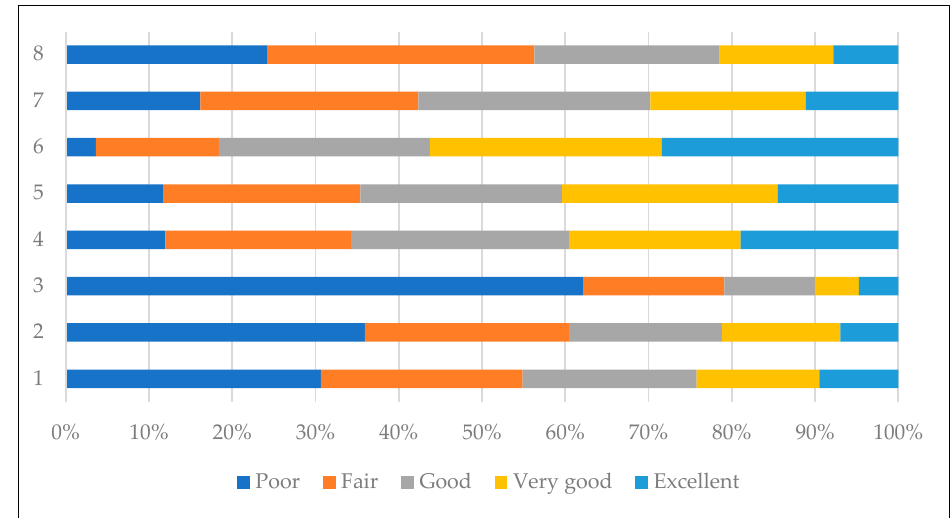
Figure 4. The level of quality of local services in the residential neighborhoods.